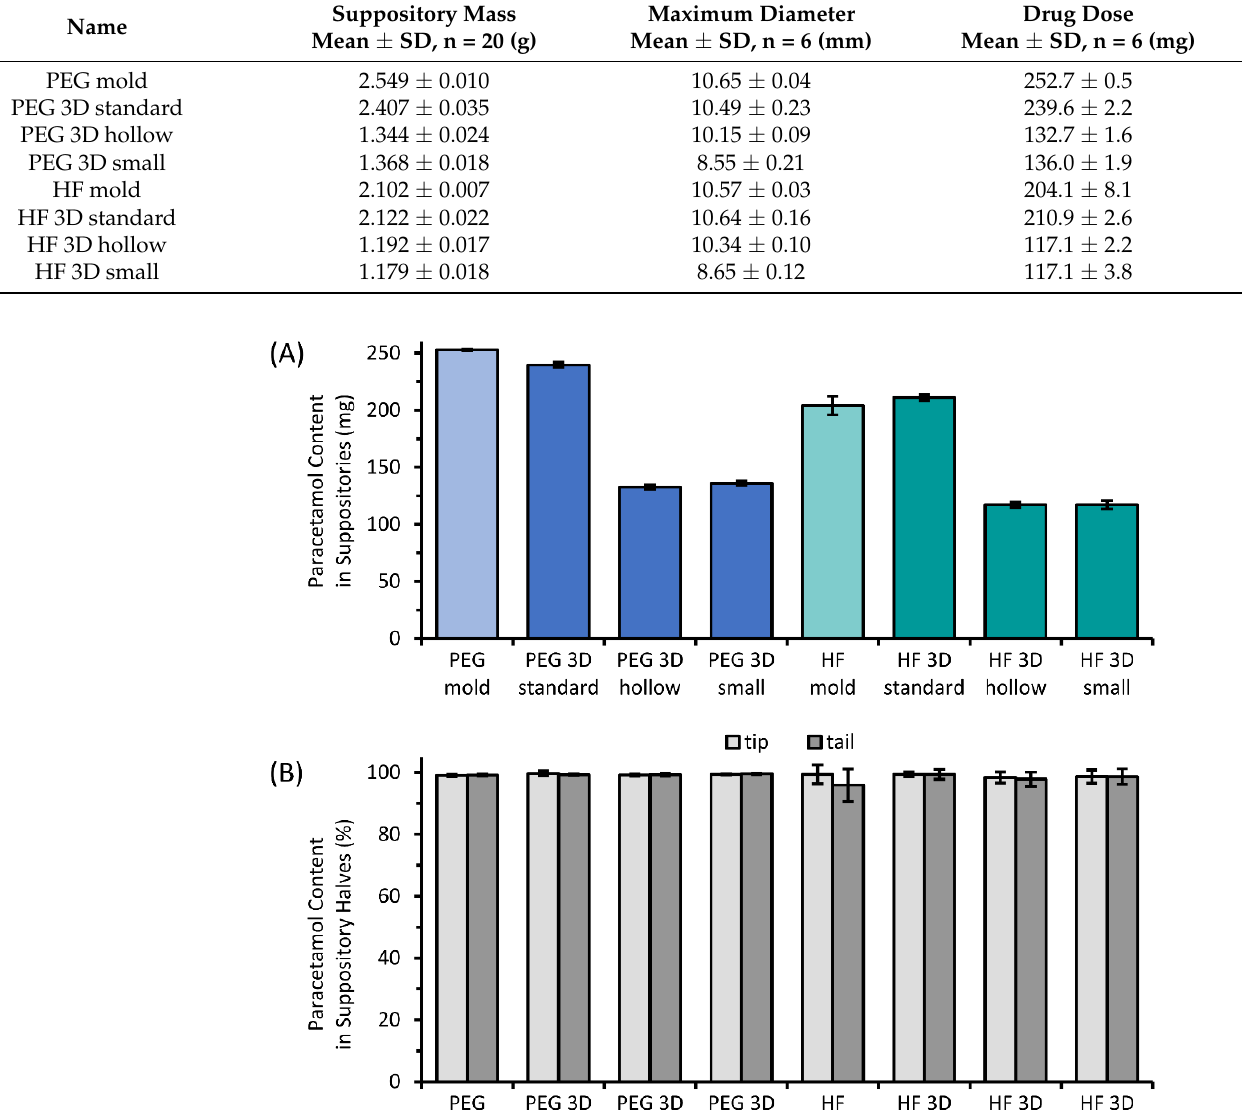
Table 3. Results of the determination of suppository masses, diameters, and drug doses (paracetamol).